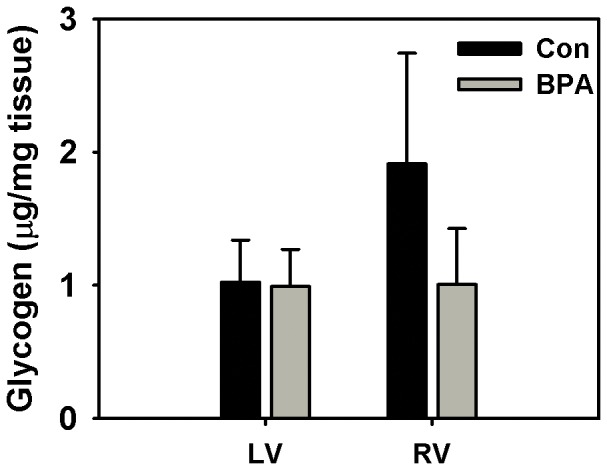
Tissue glycogen estimation.Ventricular glycogen content was assessed using a calorimetric method on the left ventricle (LV) and the right ventricle (RV) of rhesus monkey (Macaca mulatta) fetuses at birth. Fetuses were exposed maternally to a 400 µg/Kg. body weight of BPA dose (B) or 150 µL ethanol (C) during late gestation (LG, days 100–term). Data were analyzed by tissue and bars represent the mean ± S.E.M., of the tissue glycogen content measured in µg for every milligram tissue. A two sample t-test at a two-tailed p≤0.05 was considered statistically significant.